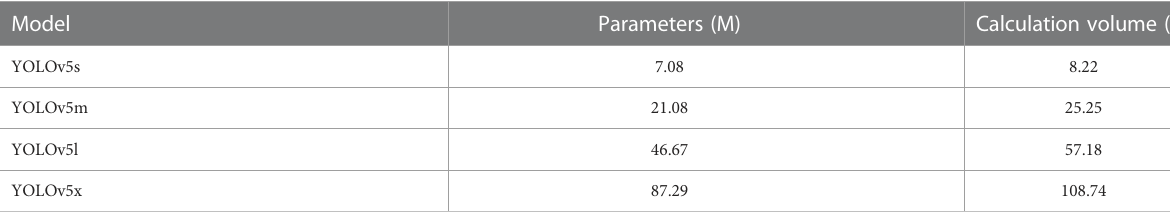
TABLE 2 Comparison of different versions of YOLOv5